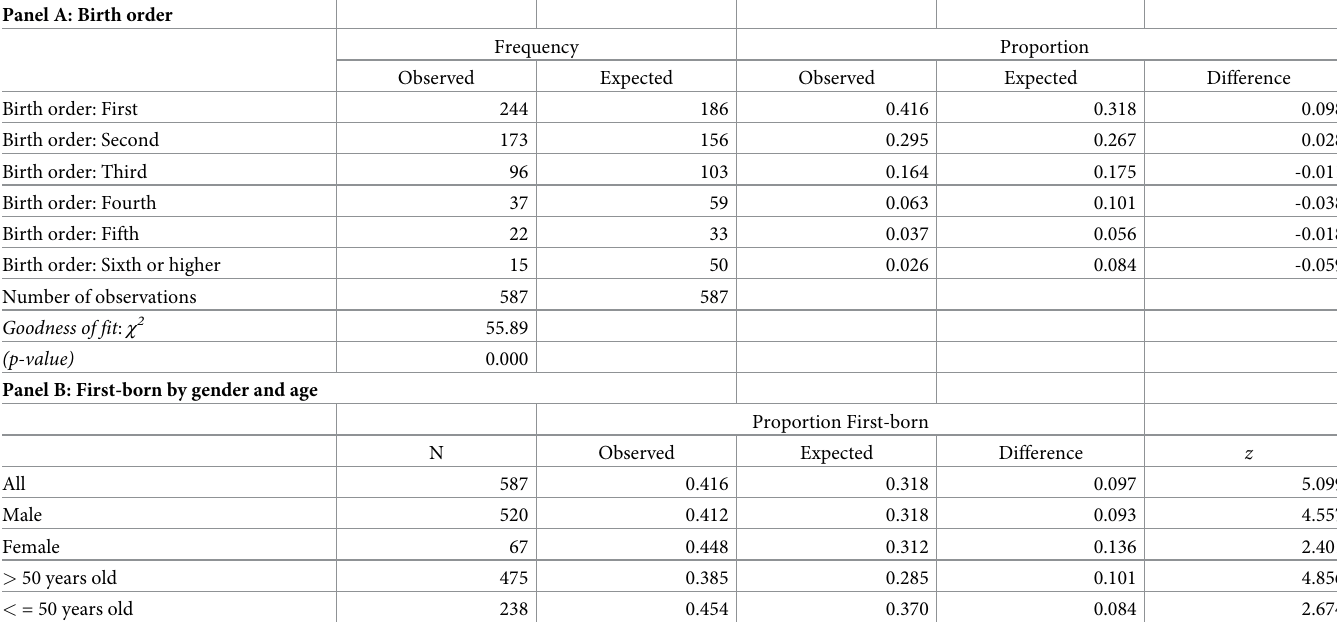
Table 7. Out of sample evidence using larger CEO